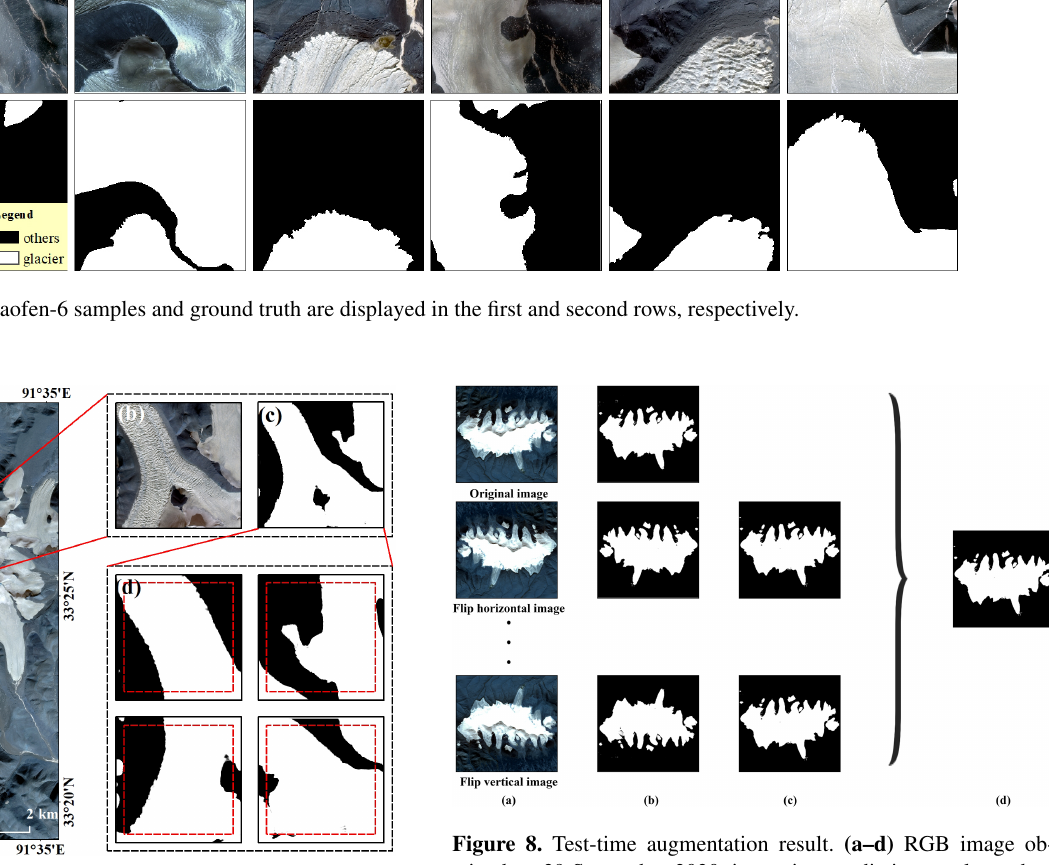
Figure 7. Postprocessing. Panels (a) and (b) are the RGB images obtained on 20 December 2020, (c) the final result of merging, and (d) the prediction results.